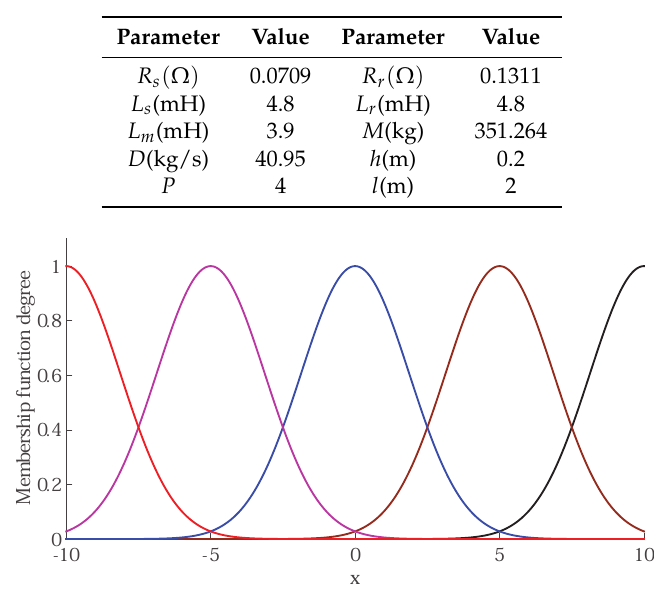
Table 1. Parameters of the investigated LIM.